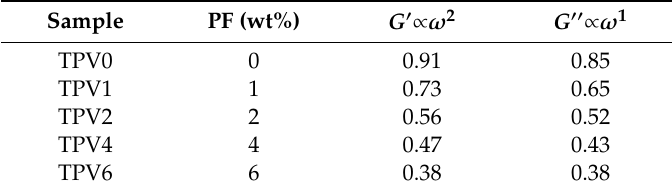
Figure 6. Changes of G ′ ( a ) and G ″ ( b ) as functions of frequency for TPVs with different PF loading. Table 1. Terminal slopes of G ′ and G ″ for TPVs.